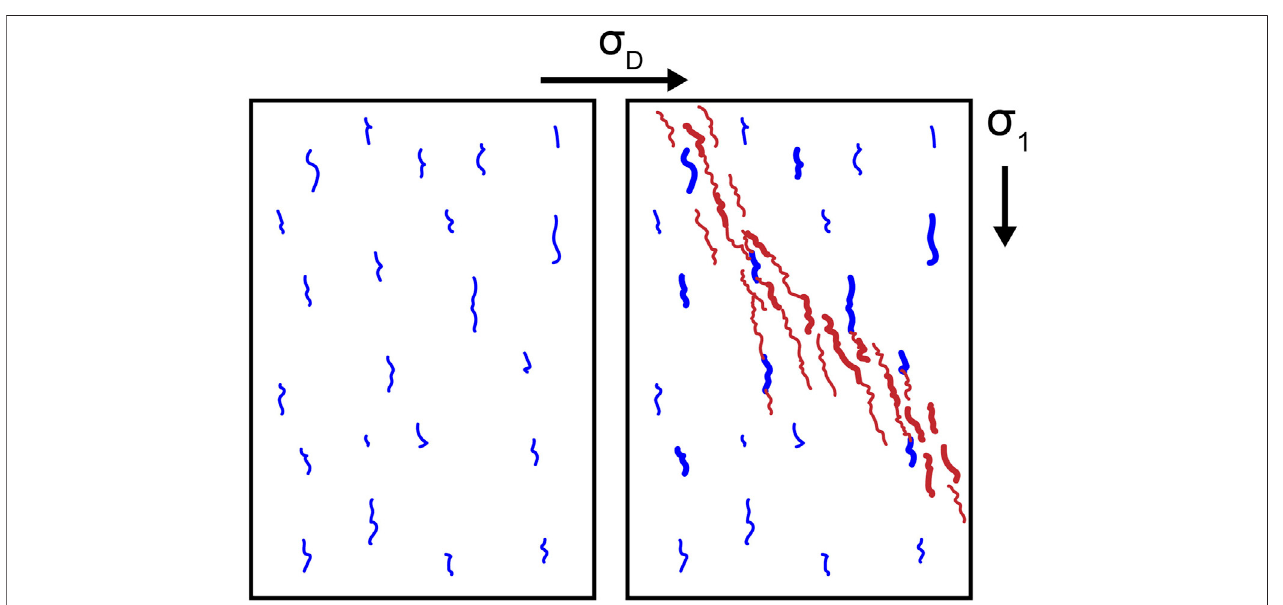
FIGURE 1 | Transition from stable (left) to unstable (right) fracture network development via coalescence of fractures with increasing differential stress, σ D . Left: Under lower σ D , microfractures nucleate and grow parallel to the main compressive stress, σ 1 . Right: With increasing σ D , approaching system-size failure, the microfractures grow, interact, and link to form a connected fault.